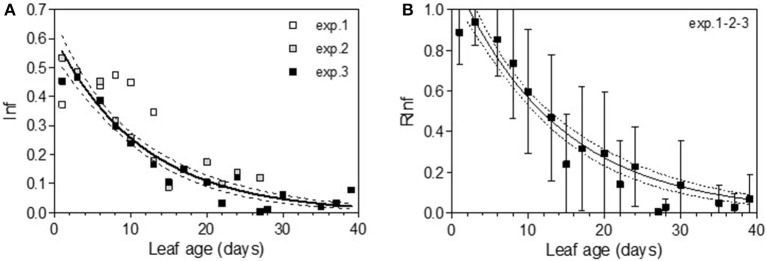
Infection efficiency rate (Inf) (A) and relative infection efficiency rate (RInf) (B) as a function of leaf age for experiments on Cabernet Sauvignon. Bars indicate standard deviations. Plain lines correspond to the fitted model M1 in Table 4. Dashed lines correspond to the 95% confidence bands on the models.